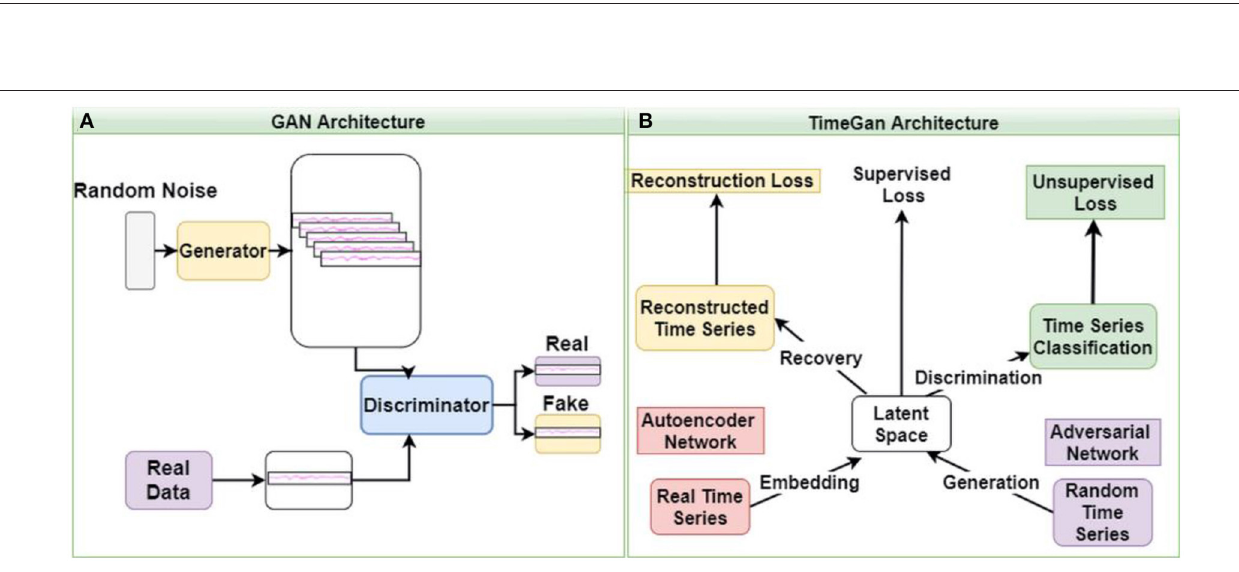
Frontiers in Neurology |